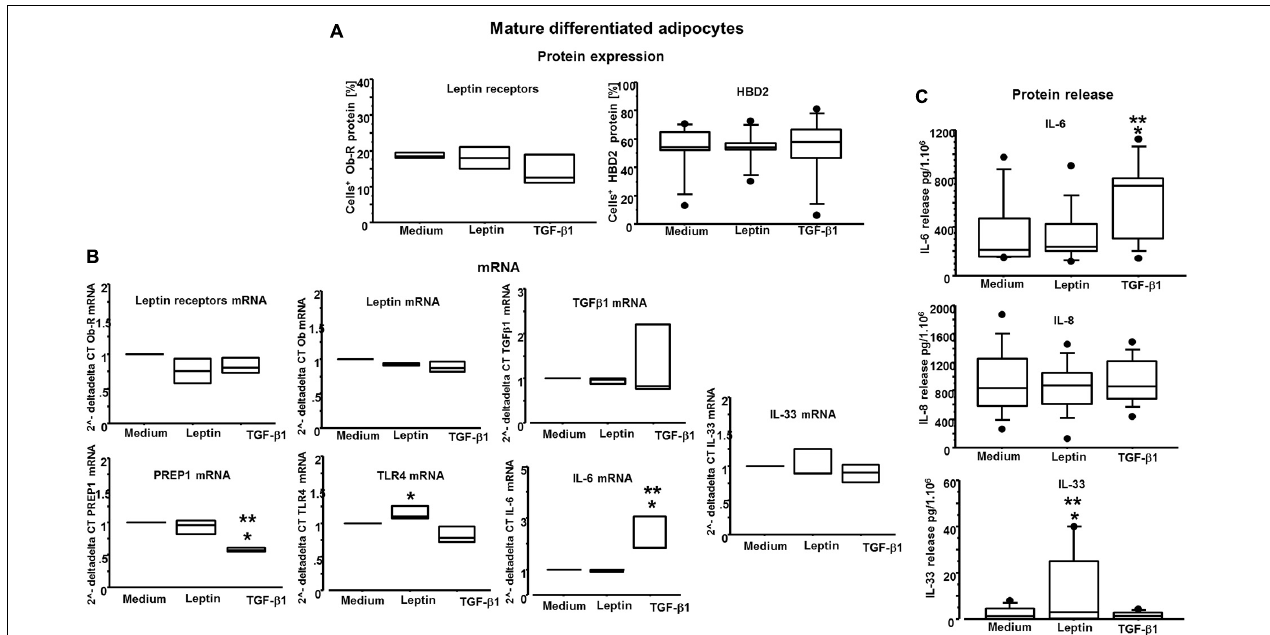
FIGURE 8 | (A) Flow cytometry analysis on mature differentiated adipocytes for leptin receptors and HBD2: there are no significant differences among the conditions. (B) n = 3 experiments; quantitative real-time PCR of leptin and its receptors, TGF- β 1 and IL-33 transcripts: there are no significant differences among the conditions; RT-PCR of PREP1 transcripts is significantly reduced only by TGF- β 1 (400 nM) versus medium (* p = 0.0008) and versus leptin (0.05 µ M) (** p = 0.0022); RT-PCR of TLR4 transcripts is significantly increased only by leptin (0.05 µ M) versus TGF- β 1 (400 nM) (* p = 0.0143); RT-PCR of IL-6 transcripts: it is significantly increased only by TGF- β 1 (400 nM) versus medium (* p = 0.0203) and versus leptin (0.05 µ M) (** p = 0.0179). (C) At least n = 7 experiments; IL-6, IL-8, and IL-33 release by mature differentiated adipocytes: for IL-8, there are no significant differences among the conditions, whereas IL-6 was significantly increased only by TGF- β 1 (400 nM) versus medium (* p = 0.0486) and versus leptin (0.05 µ M) (** p = 0.0199), and IL-33 was significantly increased only by leptin (0.05 µ M) versus medium (* p = 0.0486) and versus TGF- β 1 (400 nM) (* p = 0.0424). Analysis of variance (ANOVA), Fisher’s